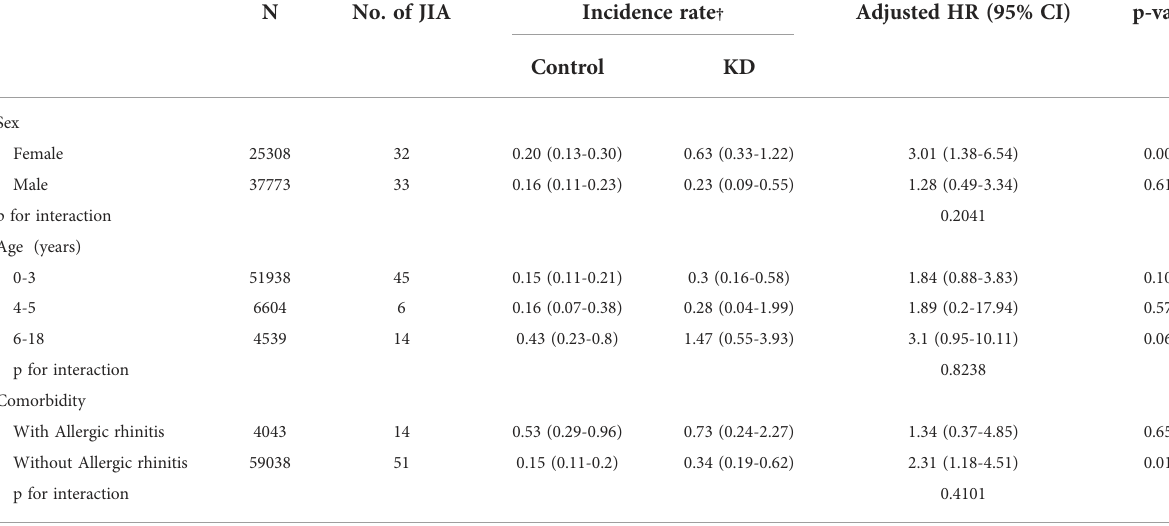
TABLE 4 Subgroup analysis: Relationship between KD and JIA development.